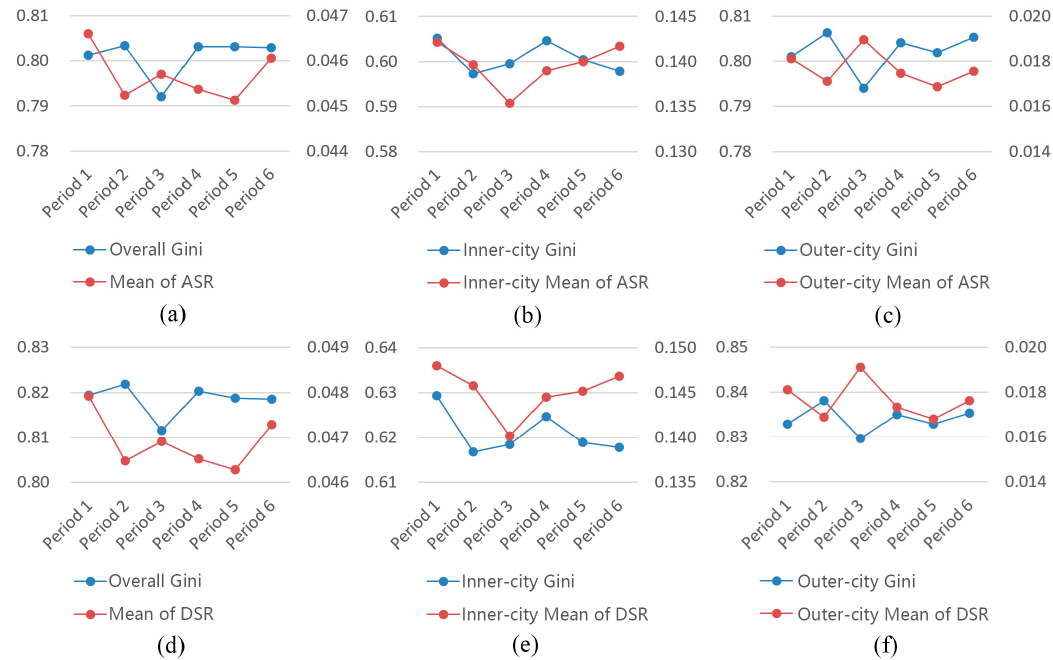
Figure 3. The changes of Gini coefficient and the changes of the mean of service rate on weekdays during the subsidy war. Specifically, they are the overall changes of the Gini coefficient and mean of ASR ( a ), the changes of the inner-city Gini coefficient and the inner-city mean of ASR ( b ), the changes of outer-city Gini coefficient and the outer-city mean of ASR ( c ), the overall changes of the Gini coefficient and the mean of DSR ( d ), the changes of inner-city Gini coefficient and the inner-city mean of DSR ( e ), and the changes of the outer-city Gini coefficient and the outer-city mean of DSR ( f ).